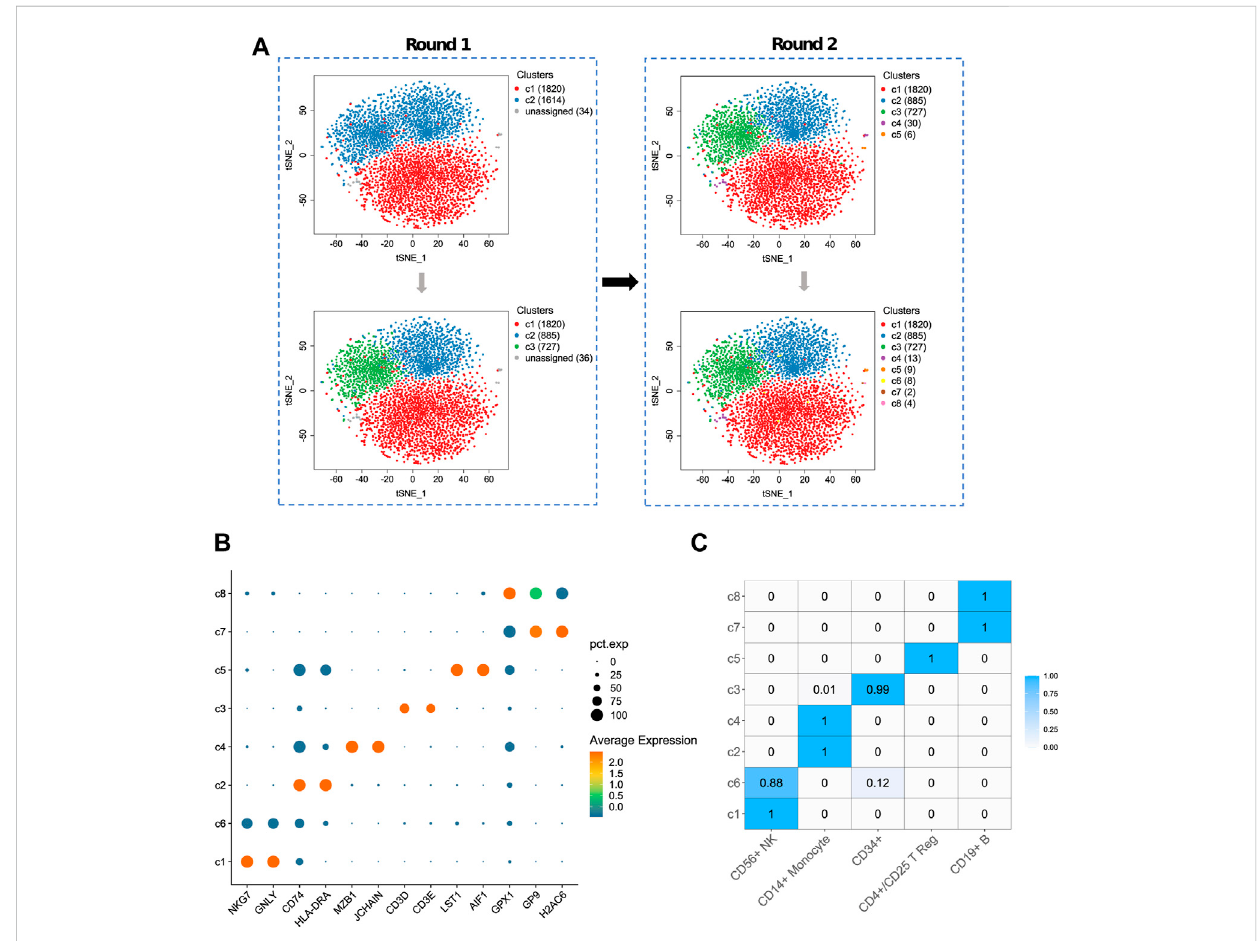
FIGURE 5 The result of ProgClust on sampled data 2. (A) Clustering trees; (B) A bubble plot of top differentially expressed genes for each cluster; (C) The confusion matrix between the clustering result and the ground truth. The value denotes the proportion of each cell type in the